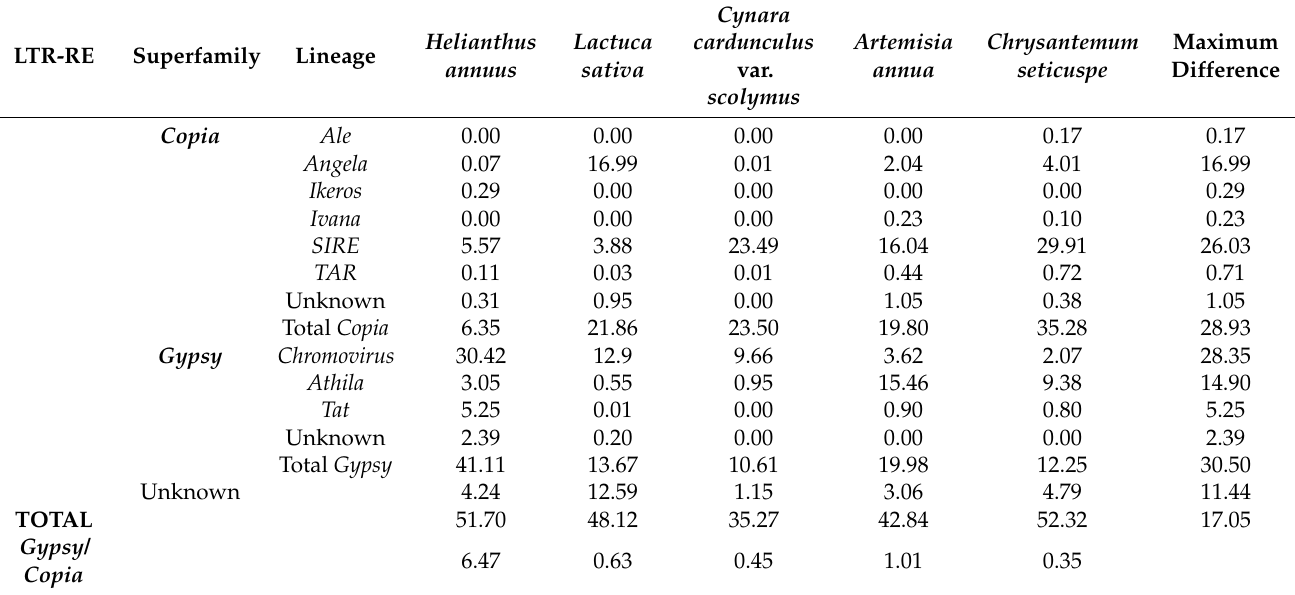
Table 3. Genome proportion of LTR-RE sequences, expressed as percentage, and maximum difference among the five Asteraceae species. LTR-RE = long terminal repeat